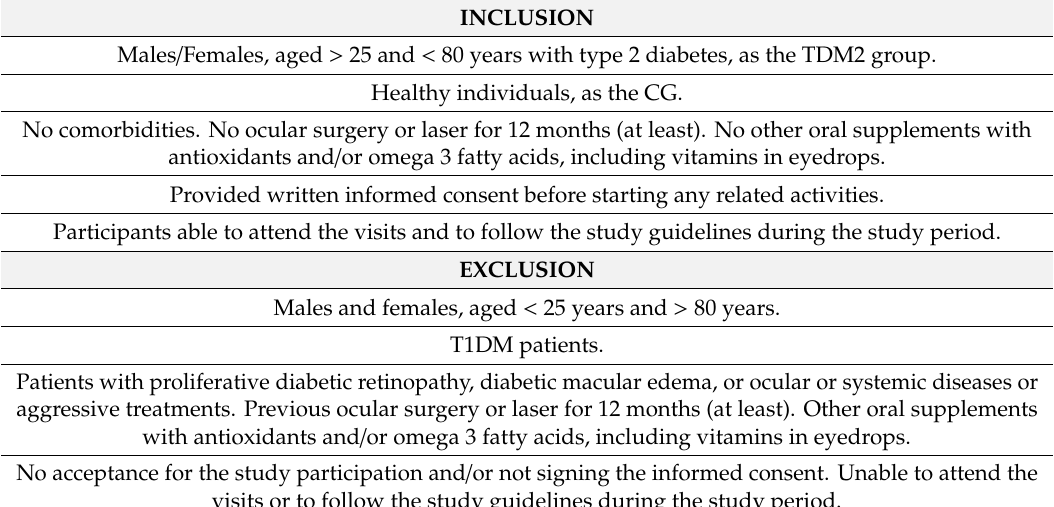
Table 1. Inclusion and exclusion criteria for the study on diabetic retinopathy.